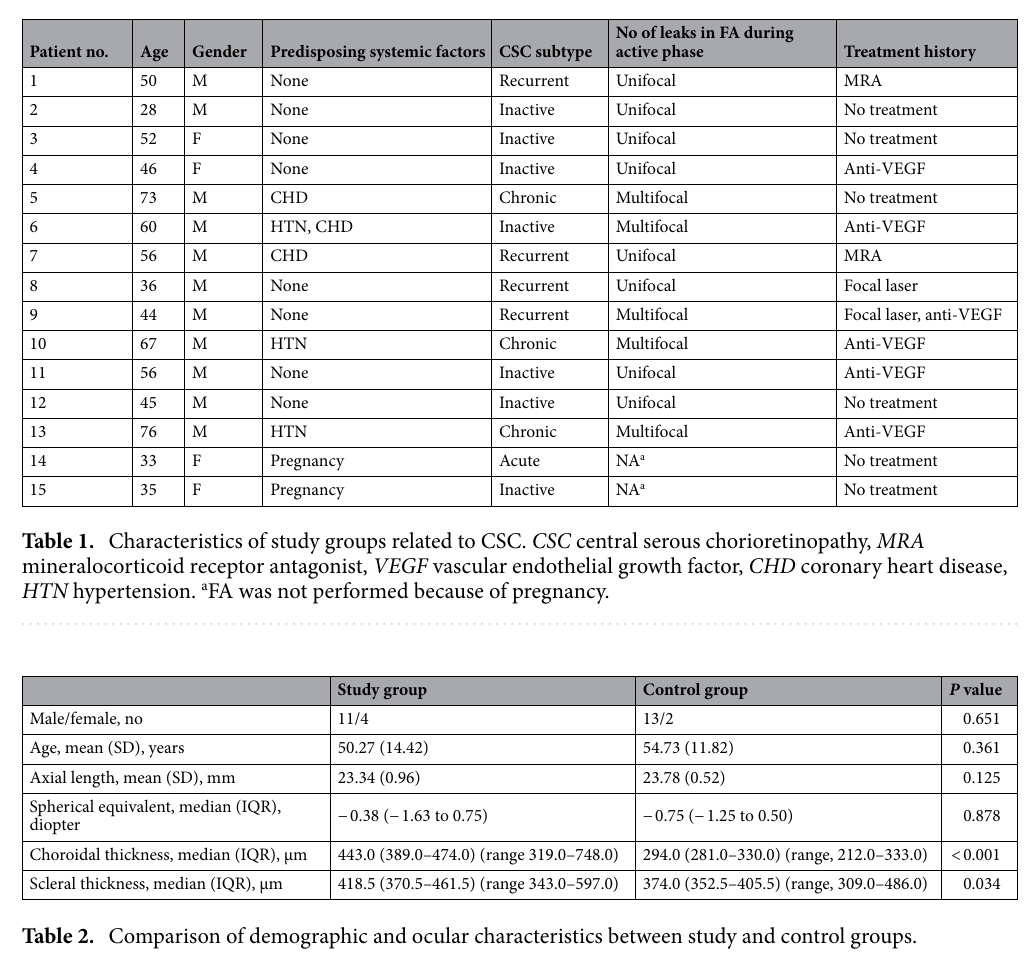
Table 2. Comparison of demographic and ocular characteristics between study and control groups.